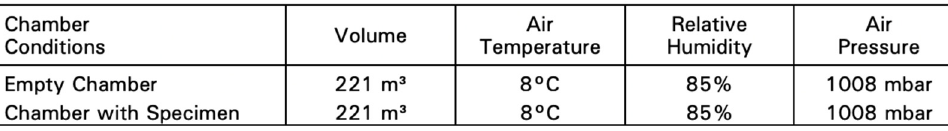
Figure 3. Conditions for conducting experiments.